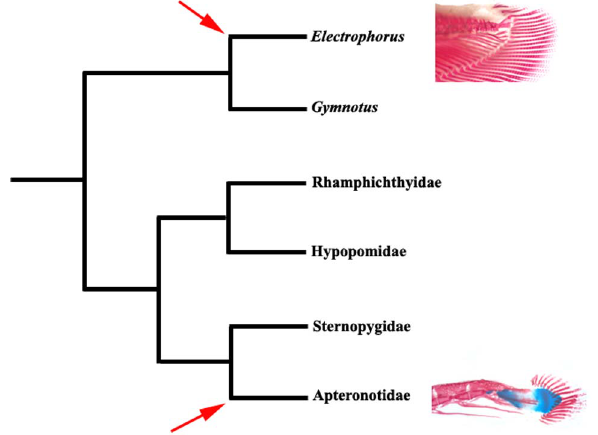
Figure 7. Phylogenetic relationships in Gymnotiformes based on [ 1,17,25 ] illustrating most parsimonious hypothesis for origins of caudal skeleton. Electrophorus + Gymnotus = Gymnotidae; arrows indicate presence of caudal fin complex in Apteronotidae and Electrophorus.